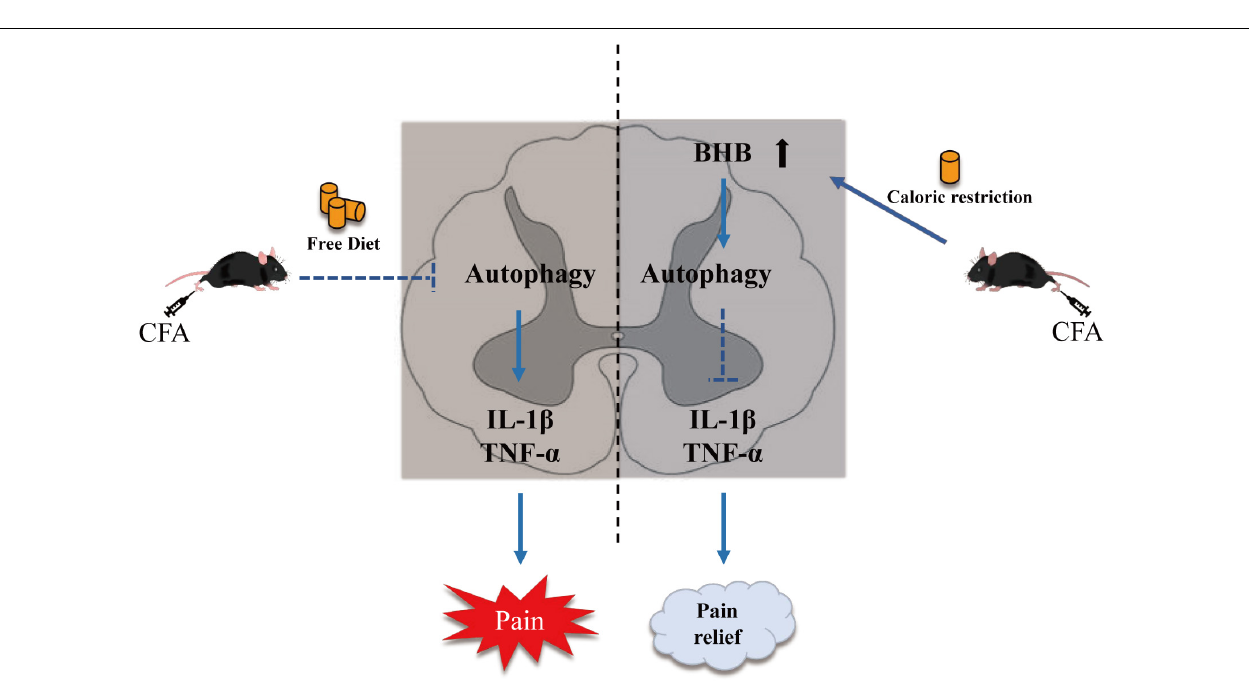
FIGURE 6 | Schematic diagram showing the mechanism by which CR alleviates CFA-induced inflammatory pain. CR elevates β -hydroxybutyric acid expression and restores autophagic